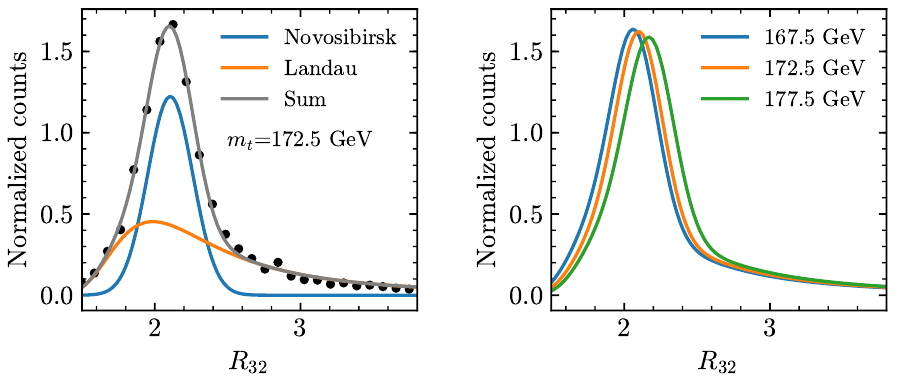
Figure 15 . The left panel gives the individual contributions of the Novosibirsk and Landau function using the best (cid:12)t parameters for the m t =172.5 GeV sample. The right panel gives the R 32 template (cid:12)ts for m t =167.5 GeV, 172.5 GeV, and 177.5 GeV, respectively, in the all-hadronic